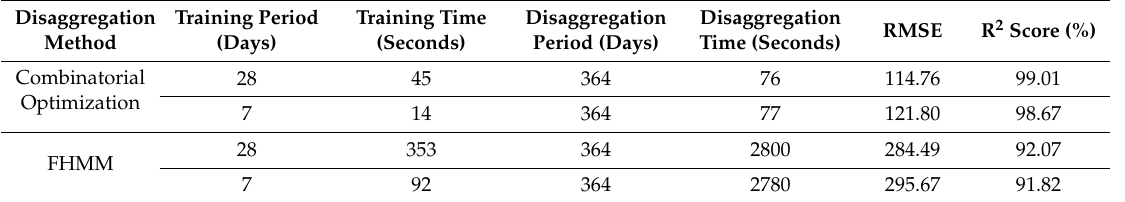
Table 1. Comparison of CO and FHMM algorithms’ accuracy and computational cost (for a PC equipped with an i5 Intel processor running at 2.2 GHz and 8 GB of memory).